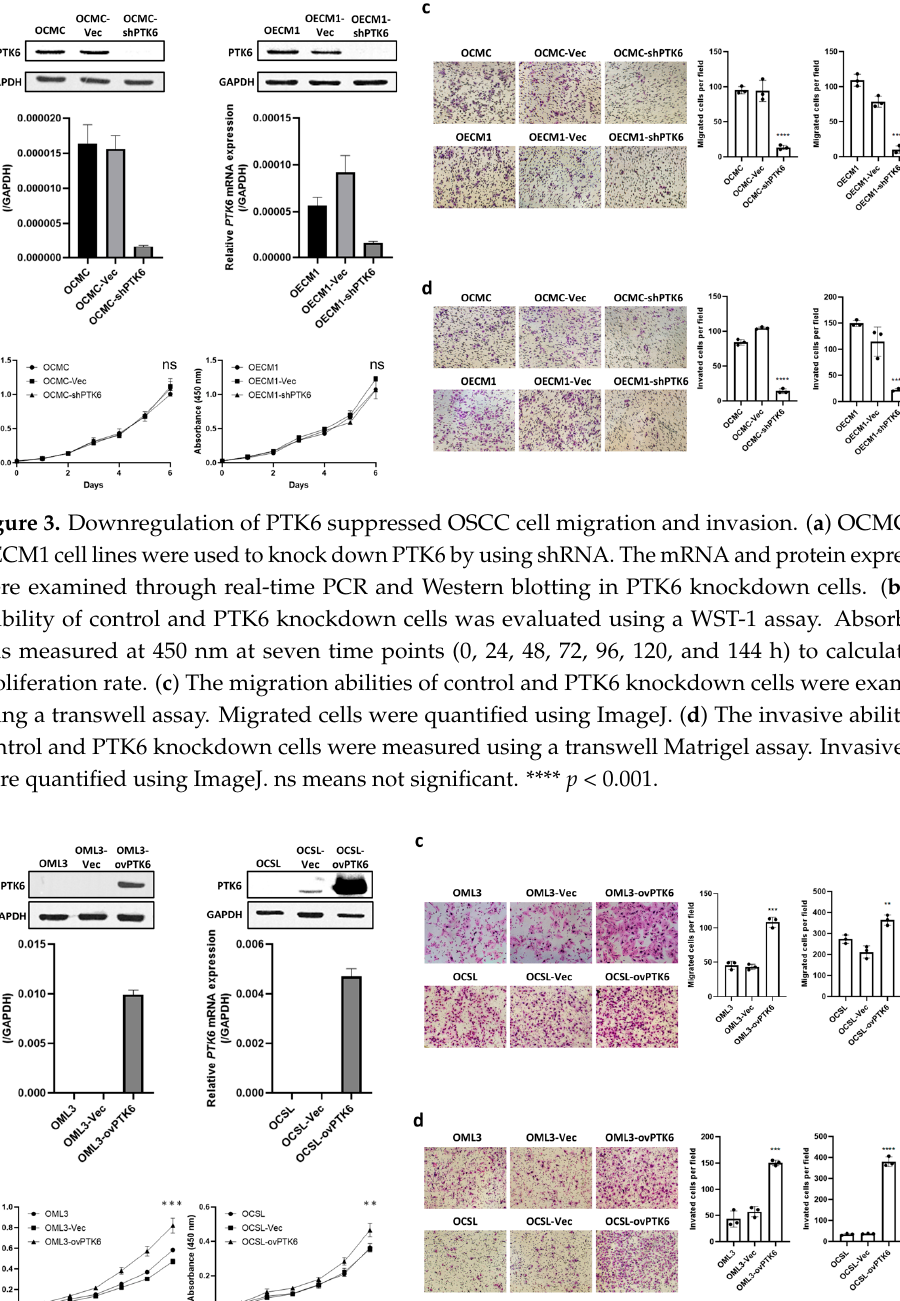
Figure 4. Upregulation of PTK6 facilitated OSCC cell migration and invasion. ( a ) PTK6 overexpres- sion was induced in OML3 and OCSL cell lines by transfecting a PTK6 overexpression plasmid. The